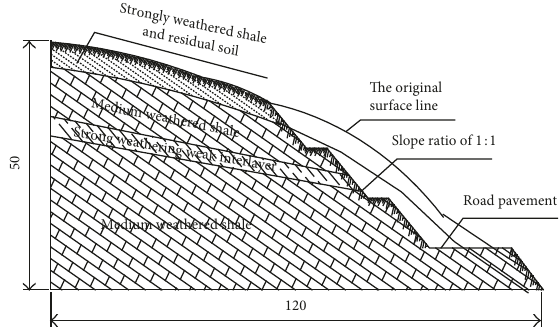
Figure 1: Engineering slope generalized